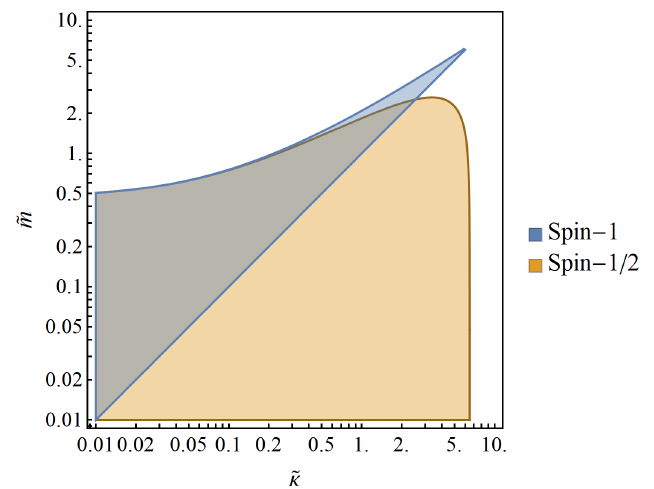
Figure 25 . The parameter region where the Ginzburg criterion (4.80) is satisfied. The blue region stands for spin-1 bosons while the yellow region stands for spin-1/2 fermions.